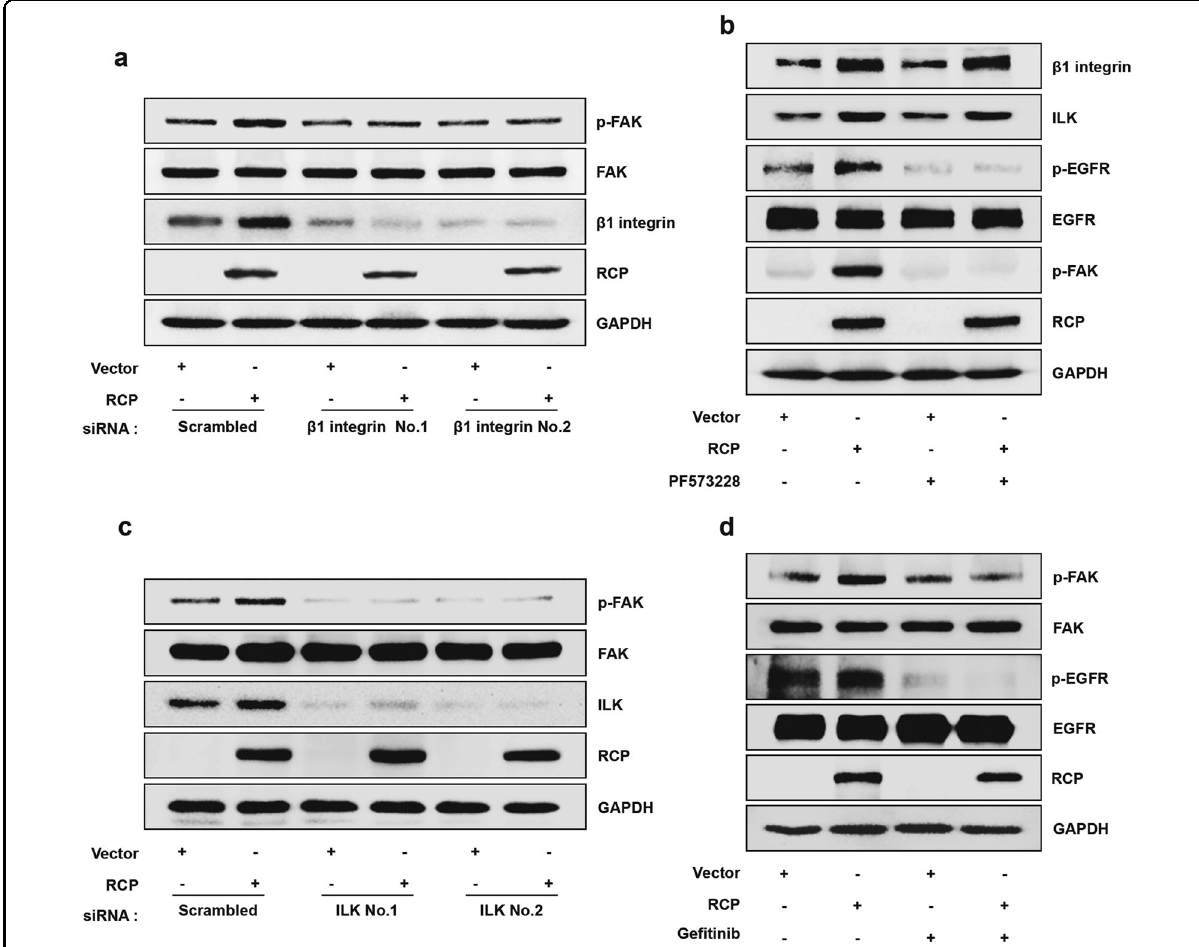
Fig. 3 FAK links β 1 integrin with EGFR. a SKOV-3 cells were co-transfected with the indicated vectors and siRNAs for 48 h. b SKOV-3 cells were transfected with the indicated vectors for 48 h, serum-starved, and treated with PF573228 (10 μ M) for 1 h. c SKOV-3 cells were co-transfected with the indicated vectors and siRNAs for 48 h. d SKOV-3 cells were transfected with the indicated vectors for 48 h, serum-starved, and treated with ge fi tinib (1 μ M) for 1 h. Immunoblotting. All experiments were repeated three